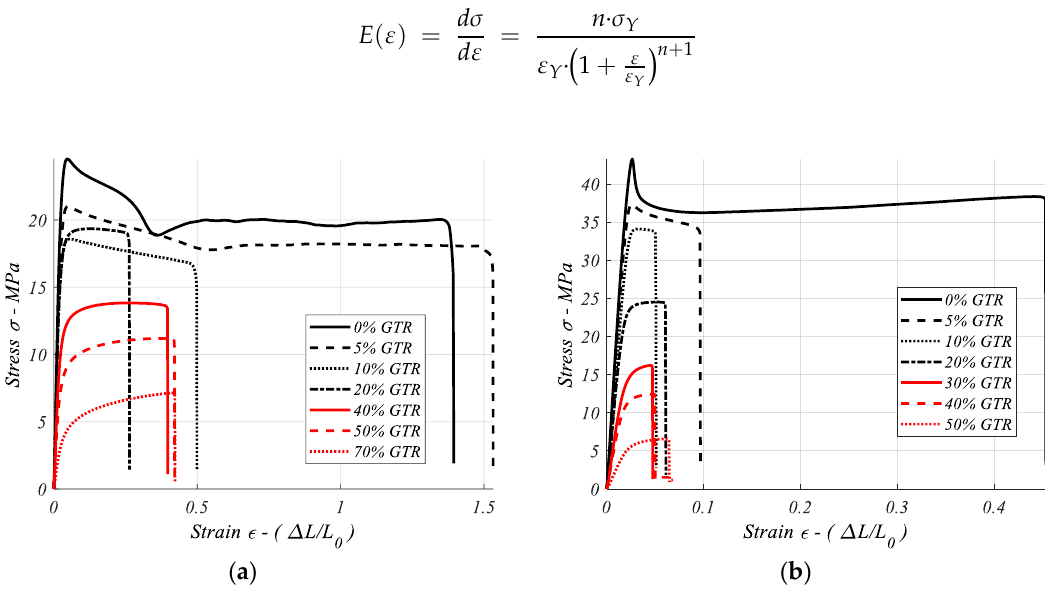
Figure 2. Curve set of Stress ( σ ) vs. Strain ( ε ) test, for several GTR concentrations. ( a ) PP, ( b )